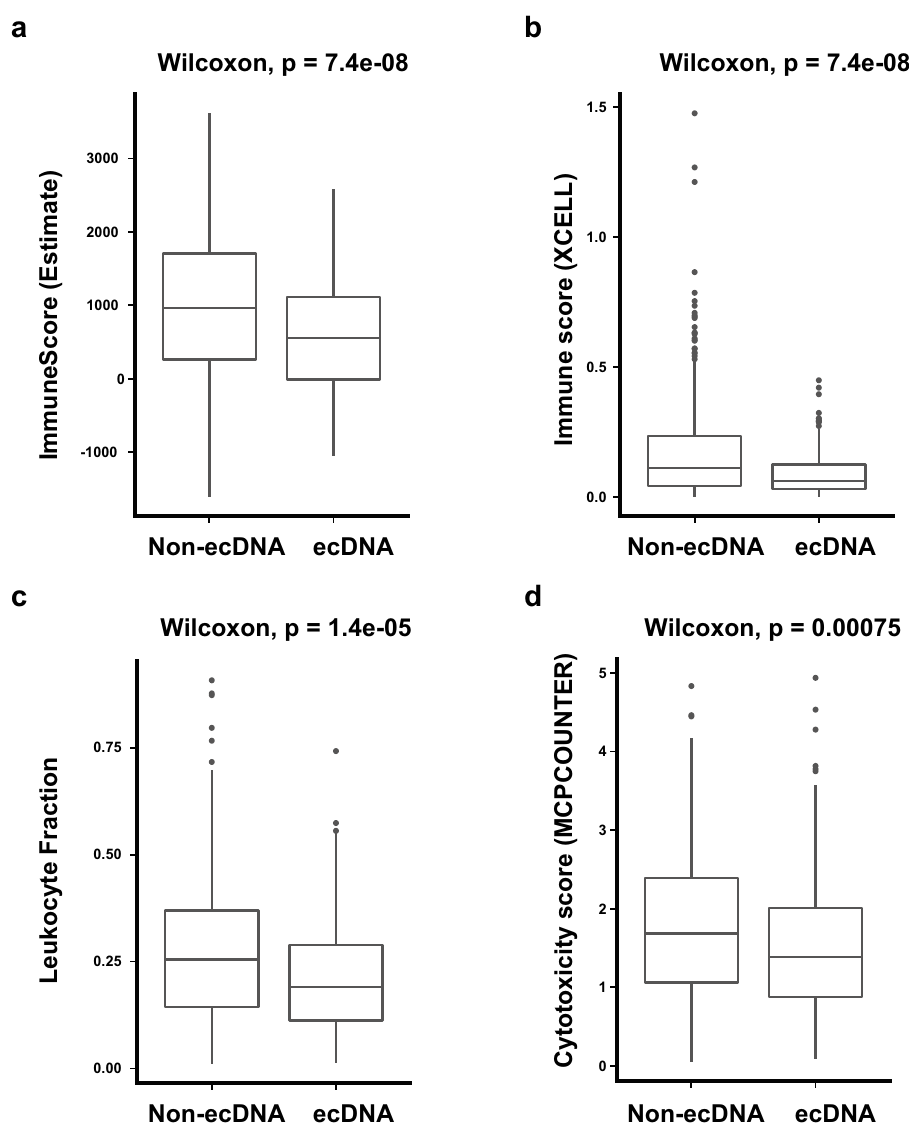
Figure 1. ecDNA and tumor immune infiltration scores. ( a – d ) Comparisons of immune infiltration scores quantified by different methods between tumors with and without ecDNA. ( a ) Estimate ImmuneScore; ( b ) XCELL Immune score; ( c ) Leukocyte fraction, ( d ) MCPCounter cytotoxicity score. Wilcoxon test P values are